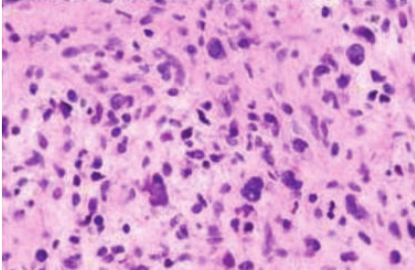
Figure 3: IHC showing cytoplasmic S-100 positivity in MPNST.